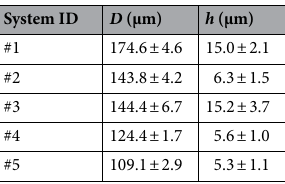
Table 1. Main properties of the microcapsules used in the